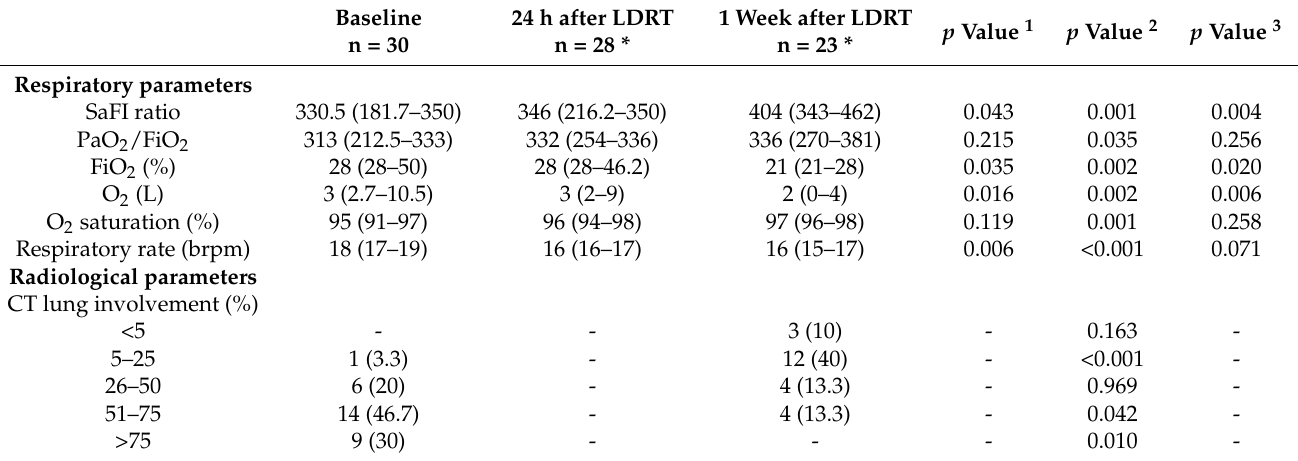
Table 2. Respiratory and radiological parameters at baseline, 24h, and 1 week after low-dose radiation therapy (LDRT).